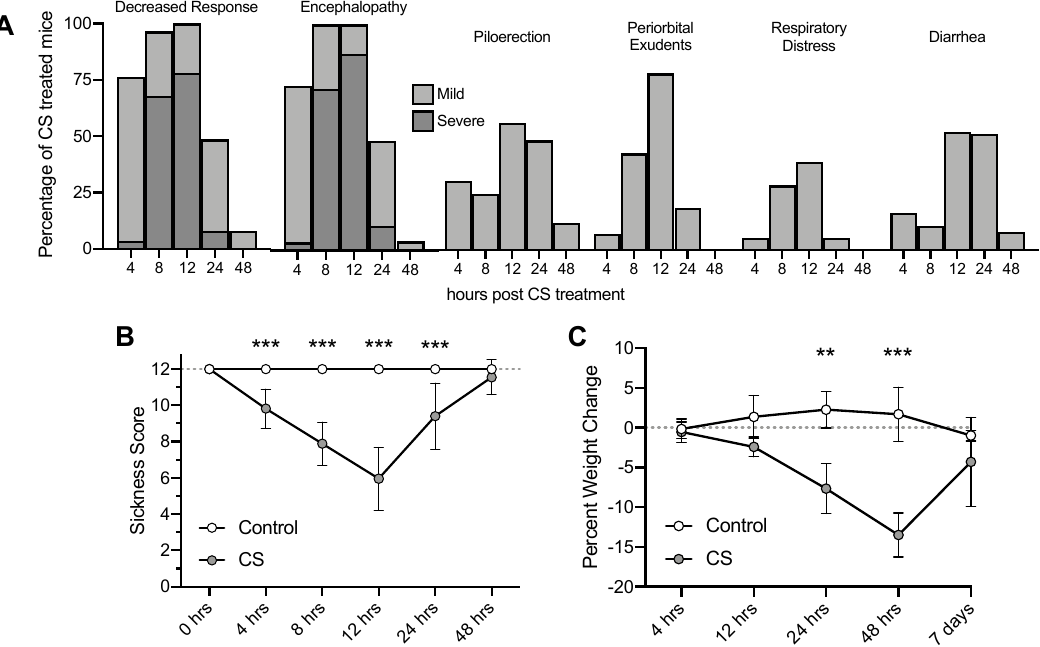
Figure 1. Observed sickness scores of mice and percent weight change over time following Cecal Slurry (CS) treatment. ( A ) Percentage of mice showing sickness behaviors and appearances. ( B ) Clinical Sickness Scores. ( C ) Weight loss. ** p < 0.01*** p < 0.001. Error bars plotted as mean ± SD.